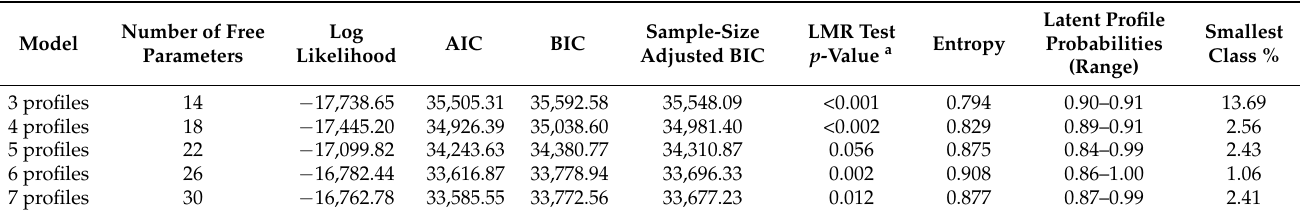
Table 1. Model fit for latent profile analysis models with different numbers of latent profiles ( n = 3765).